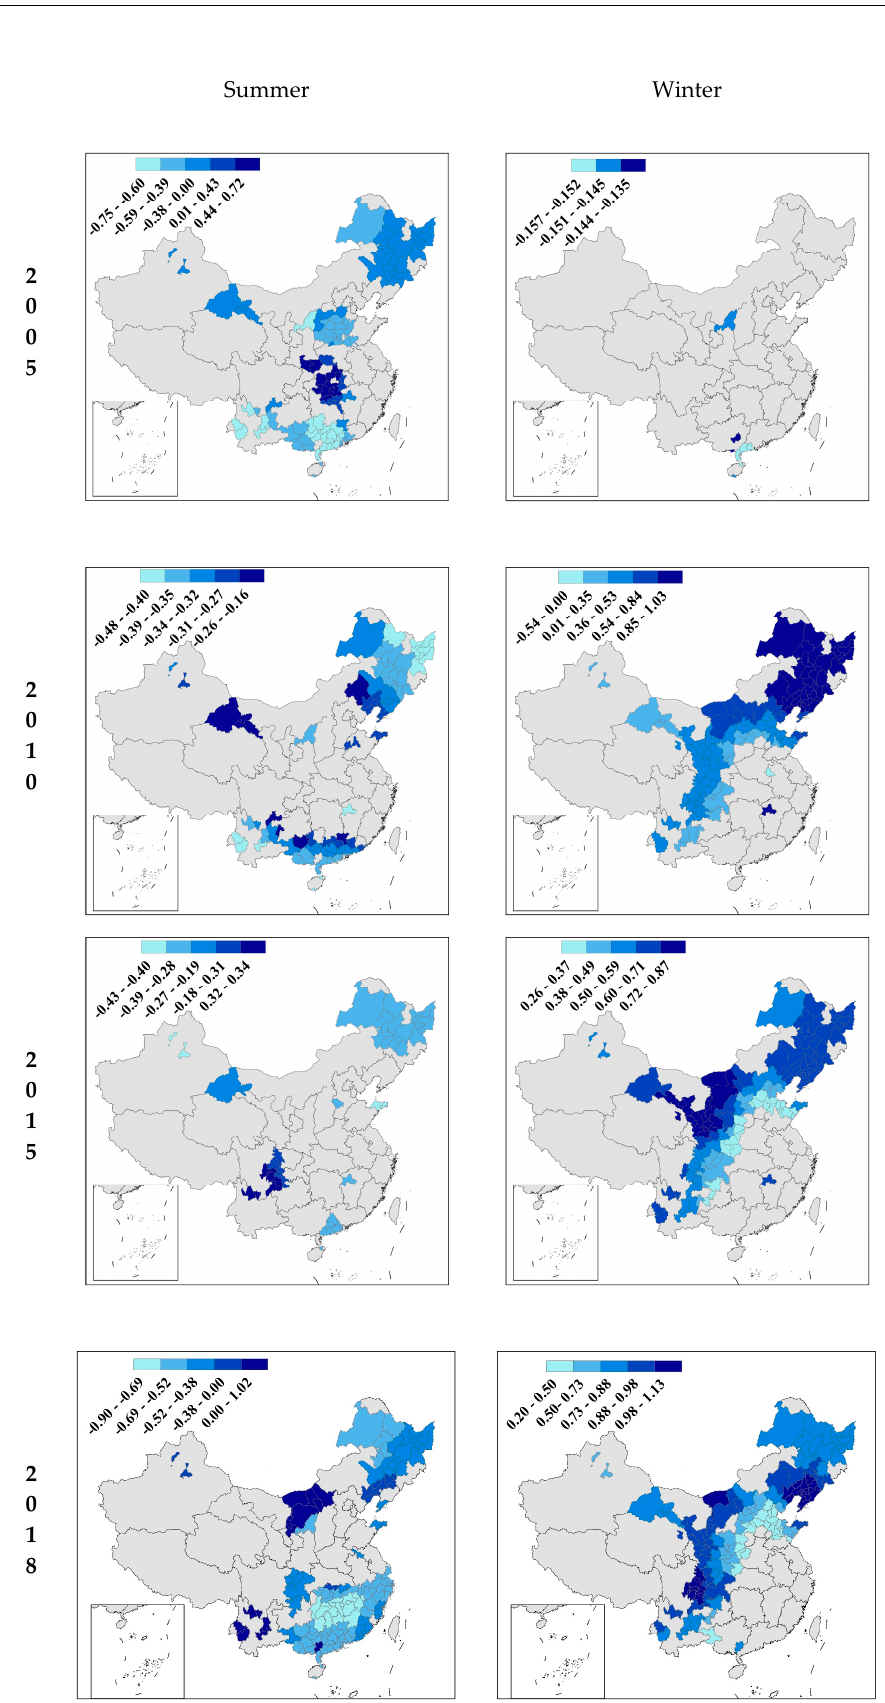
Figure 10. Spatial distributions of the coefficients of ∆ NDVI for the nighttime MGWR model in the summer and winter of 2005, 2010, 2015, and 2018.